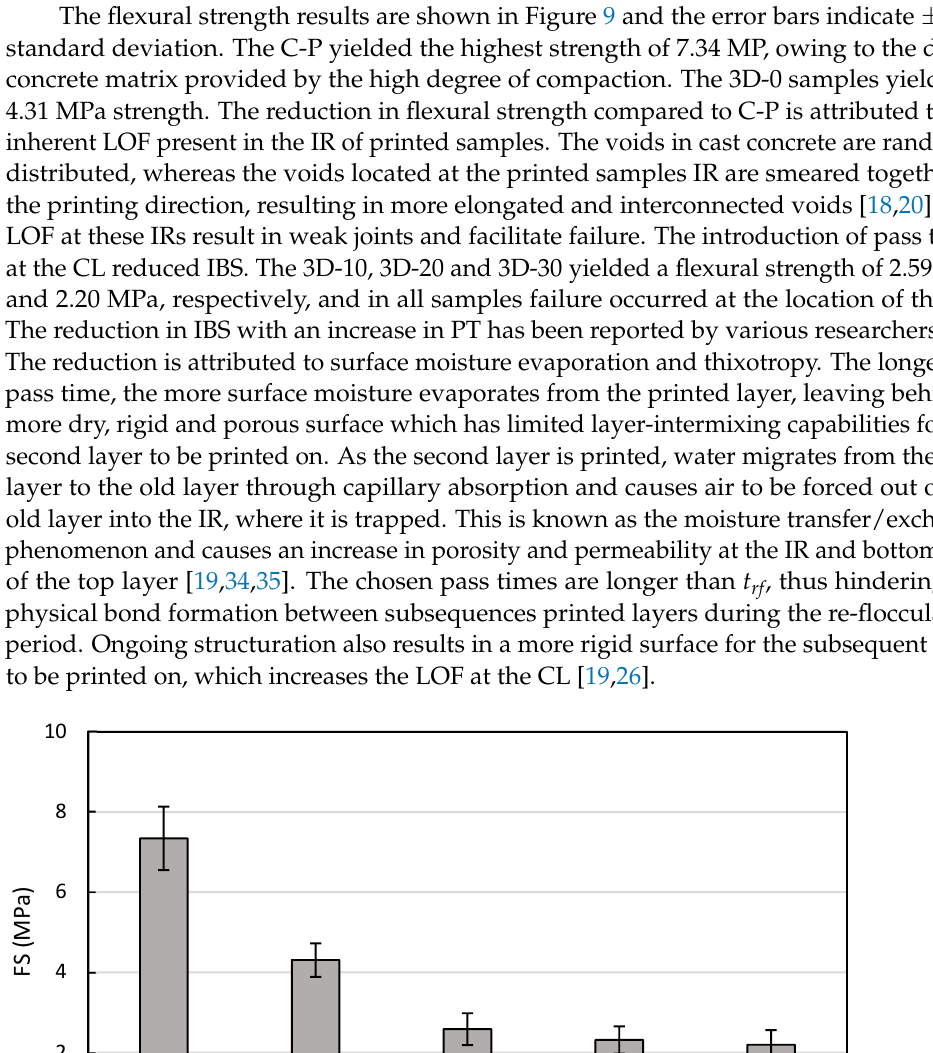
Figure 8. Chloride depth measurement points for the ( a ) cast and ( b ) printed samples.